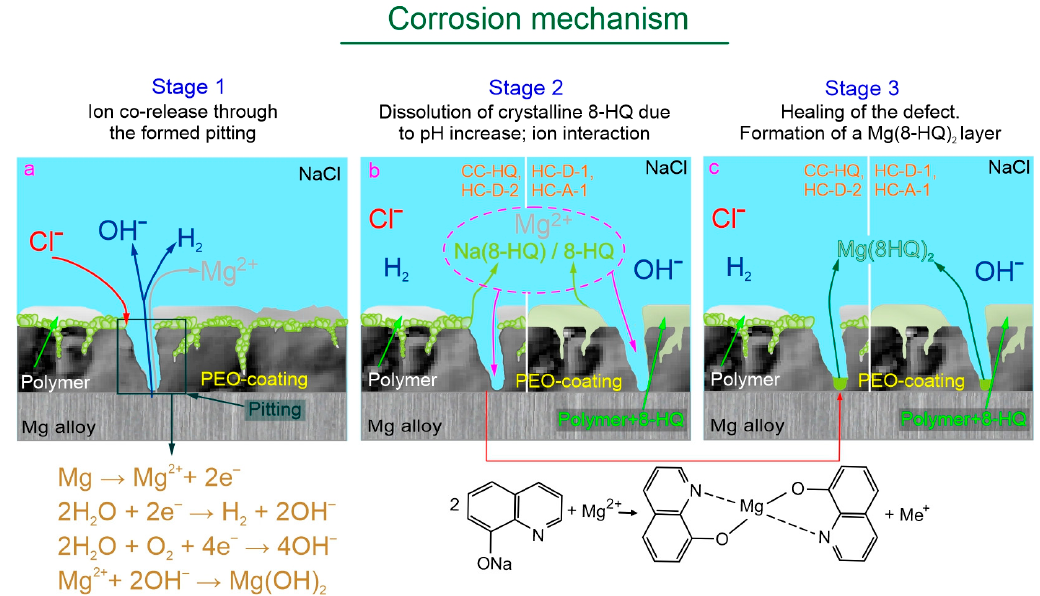
Figure 14. The schema of a self-healing mechanism of the samples with inhibitor-containing coatings. The mechanism includes three stages ( a – c ) of the protective film formation.